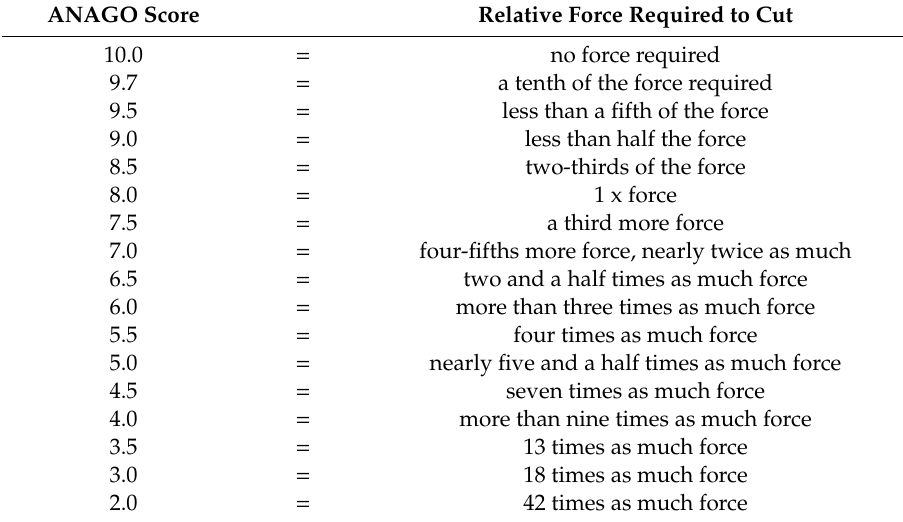
sharpness scale